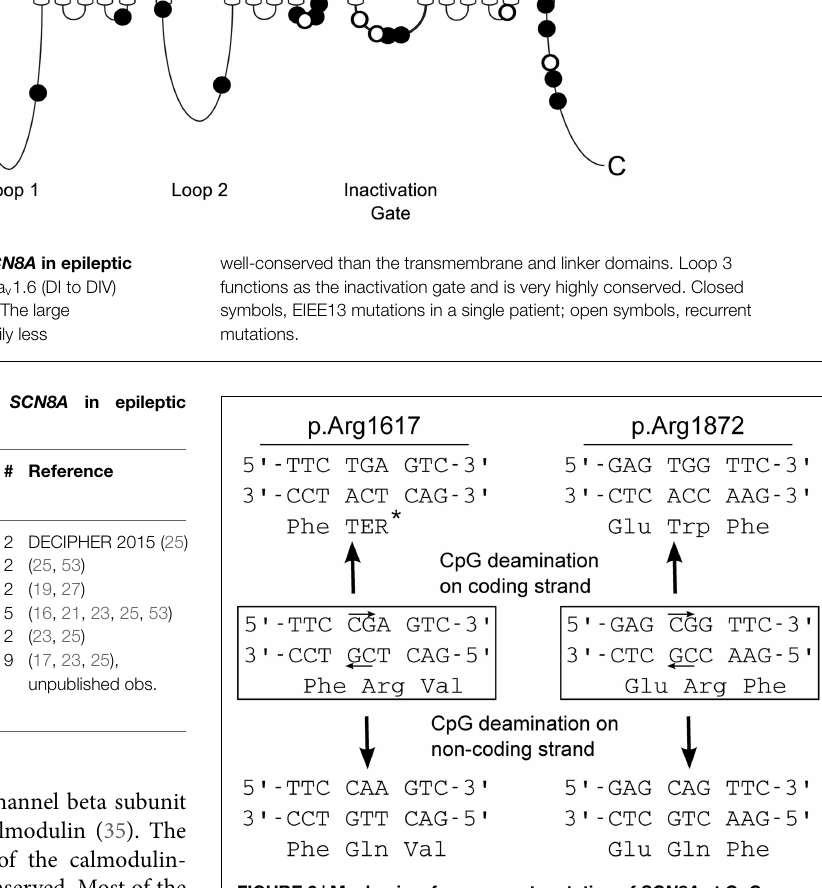
FIGURE 2 | Mechanism for recurrent mutation of SCN8A at CpG dinucleotides . Arginine 1617 is encoded by a CGA codon, and arginine 1872 is encoded by a CGG codon. Both contain CpG dinucleotides on coding and non-coding strands (small arrows). Cytosine methylation followed by deamination on either strand leads to mutation: at arginine 1617, replacement by the premature termination codon (TGA, Ter) or glutamine (Gln); at arginine 1872, replacement by tryptophan (Trp) or glutamine (Gln). The premature termination mutation p.Arg1617Ter has not been seen in EIEE13 patients, and would probably not cause seizures (see